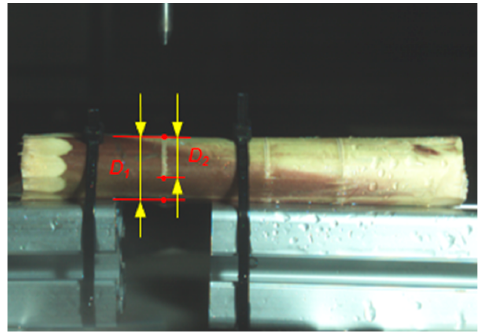
Figure 4. Cu tt ing e ff ects of water jets captured by the high-speed camera. Figure 4. Cutting effects of water jets captured by the high-speed camera.